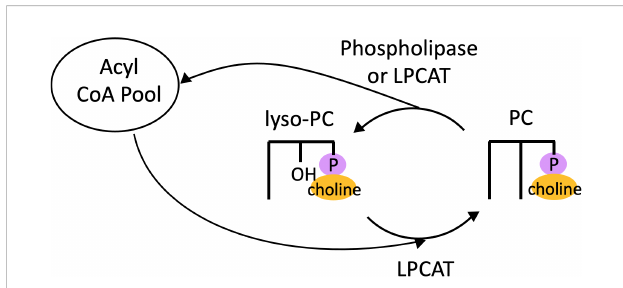
FIGURE 2 The Lands Cycle. Cycle of deacylation of PC via either a phospholipase or LPCAT to produce lyso-PC, which is then reacylated by LPCAT to regenerate PC. LPCAT, acyl-CoA:lysophosphatidylcholine acyltransferase; PC,